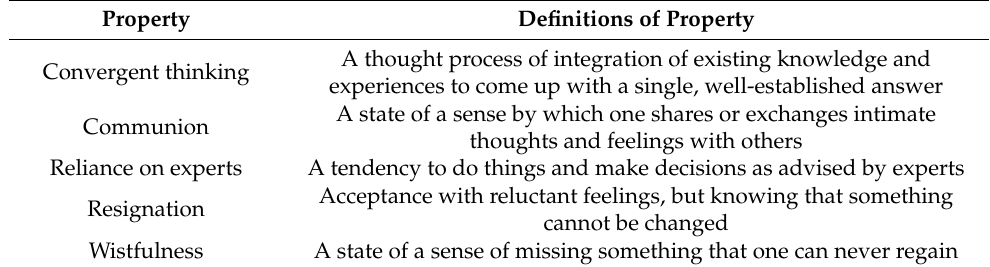
Table 8. With underlying health